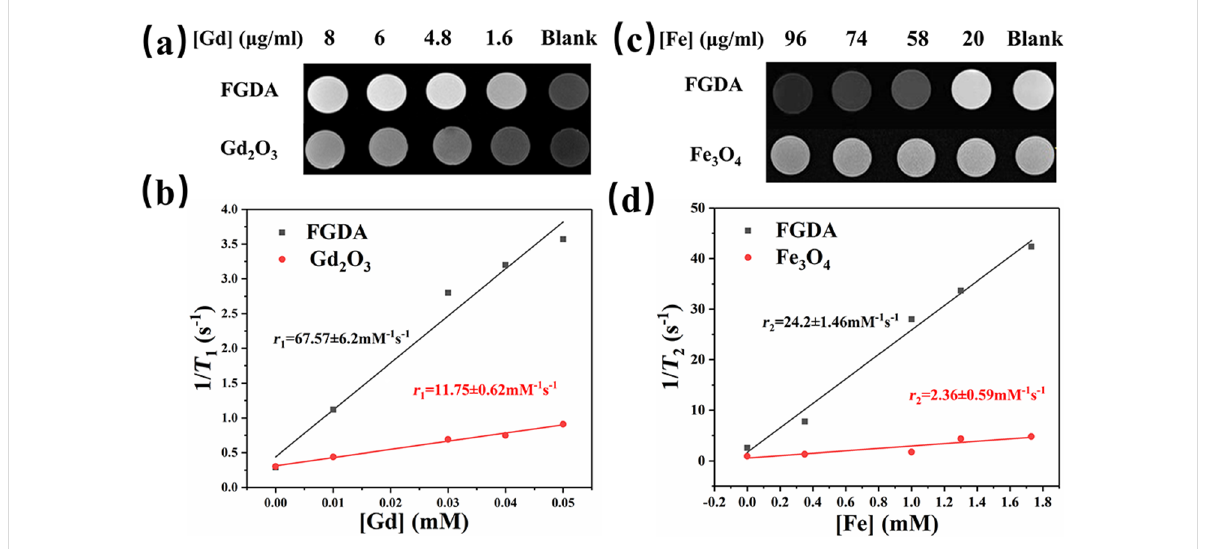
Figure 3: (a) T 1 -weigted MRI of FGDA nanocubes (top panel) and Gd 2 O 3 nanoparticles (bottom panel). (b) Longitudinal relaxation rate, r 1 , calculated for FGDA nanocubes (black line) and Gd 2 O 3 nanoparticles (red line). (c) T 2 -weigted MRI imaging of FGDA (top panel) and Fe 3 O 4 nanocubes (bottom panel). (d) Transverse relaxation rate, r 2 , of FGDA nanocubes (black line) and Fe 3 O 4 nanocubes (red